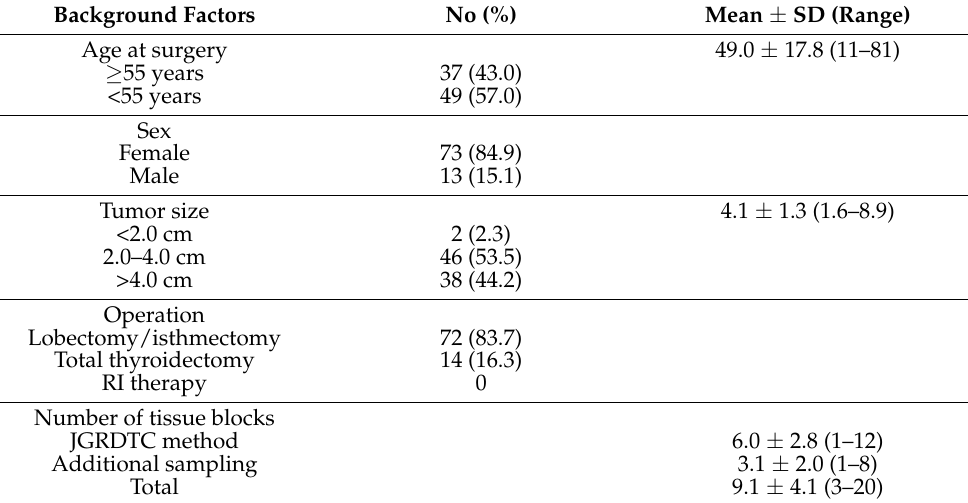
Table 2. Clinical background of the 86 patients and the numbers of tissue blocks